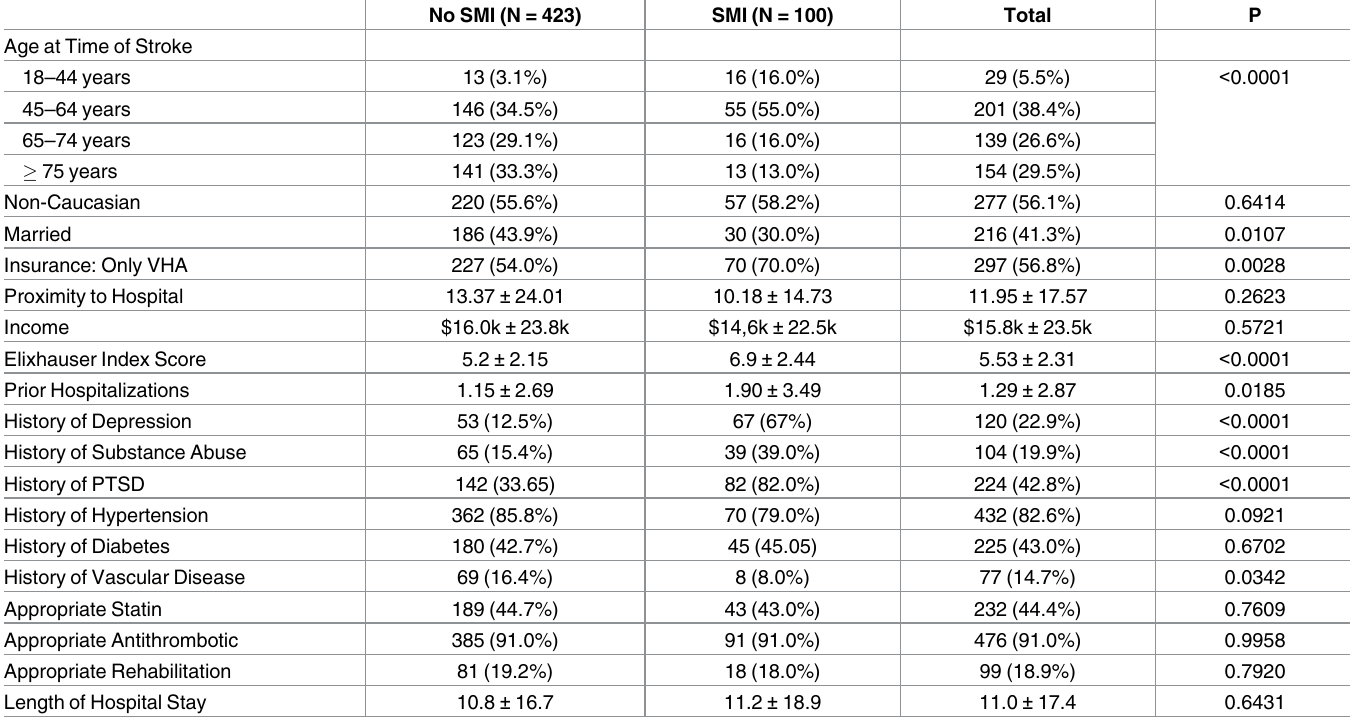
Table 2. Baseline characteristics of the study population (N = 523) at index stroke in 2003.